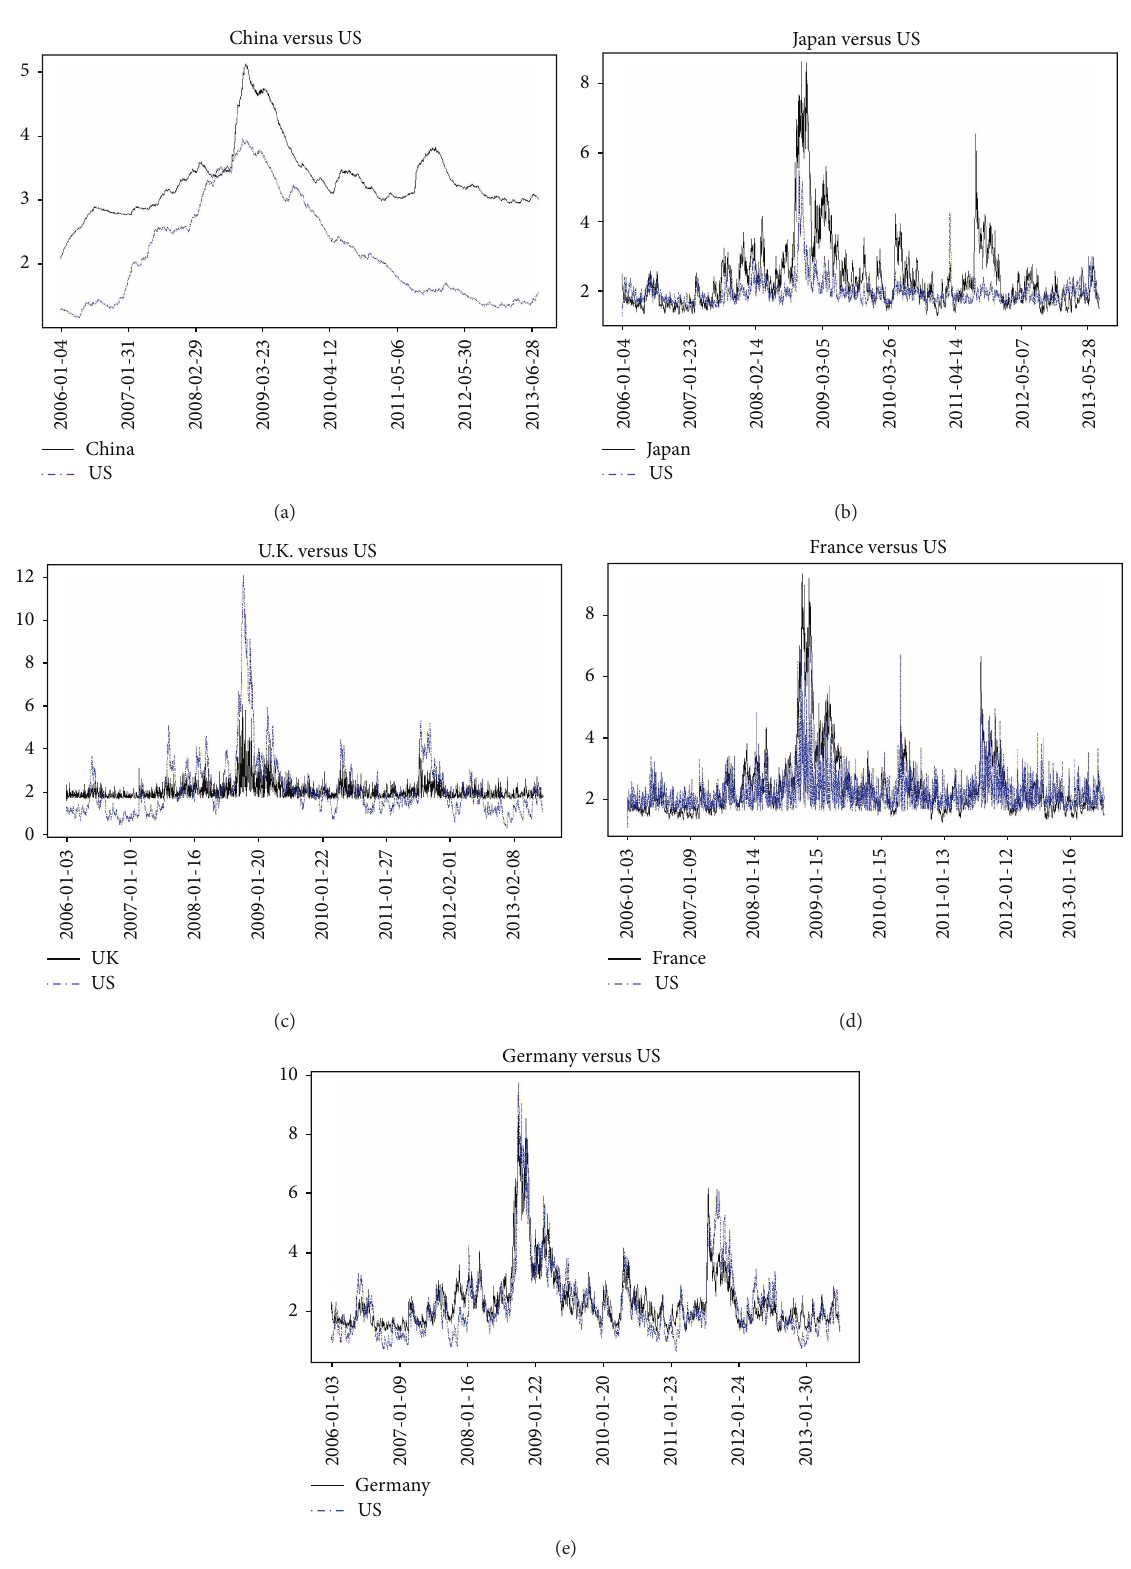
Figure 2: Estimated VaR at the level of 5% by the systems of (3). Notes: the overall sample period is from 1/2006 to